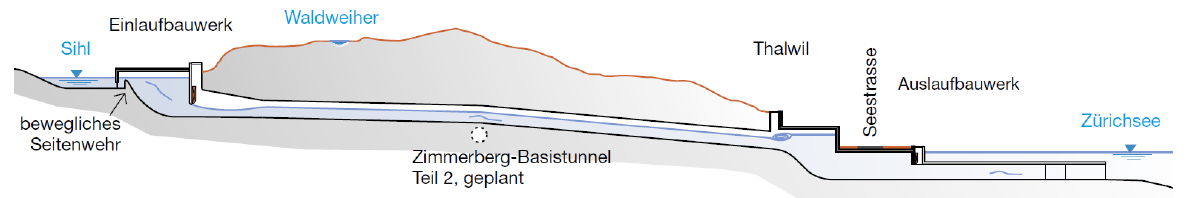
Figure 3. Longitudinal section of the gallery [3].